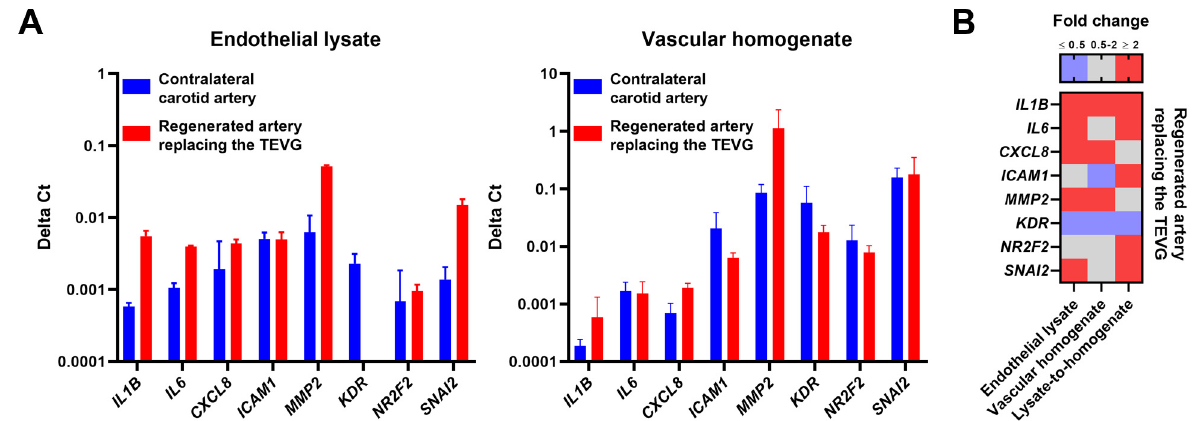
Figure 7. Transcriptional profiling of the regenerated and intact contralateral carotid arteries 18 months postimplantation. ( A ) Delta Ct values for the measured transcripts (IL1B, IL6, CXCL8, ICAM1, MMP2, KDR, NR2F2 and SNAI2) in the endothelial lysate (left) and homogenate of the de-endothelialised blood vessel (right); ( B ) Heat map indicating the differences between the endothelial lysate and vascular homogenate of the regenerated artery in relation to the respective RNA fractions in the contralateral intact artery and between endothelial lysate and homogenate of the de-endothelialised regenerated artery normalised to the mRNA expression in these compartments in the contralateral intact artery. Blue, grey and red colours mean fold change ≤ 0.50, 0.51–1.99, and ≥ 2.00, respectively, compared to the contralateral intact artery or homogenate of the de-endothelialised regenerated artery.